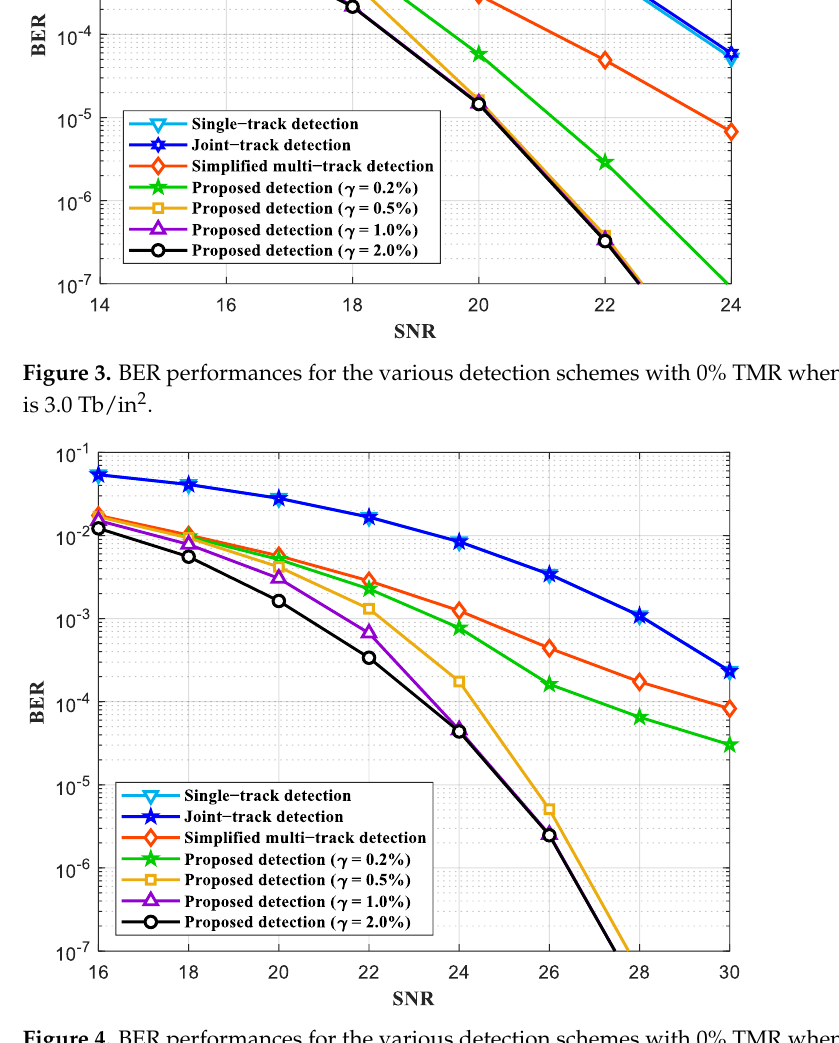
Figure 3. BER performances for the various detection schemes with 0% TMR when an areal density is 3.0 Tb/in 2 .